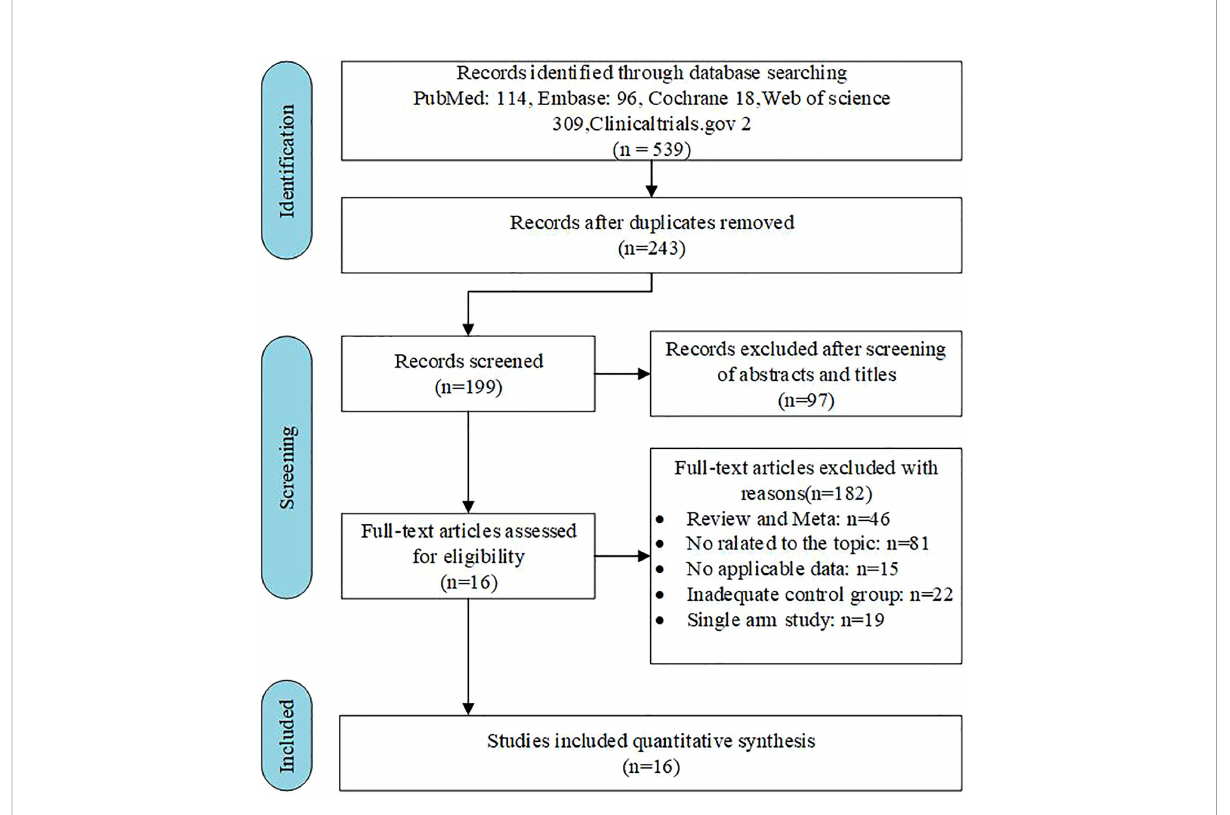
FIGURE 1 Flow chart of the search process for the